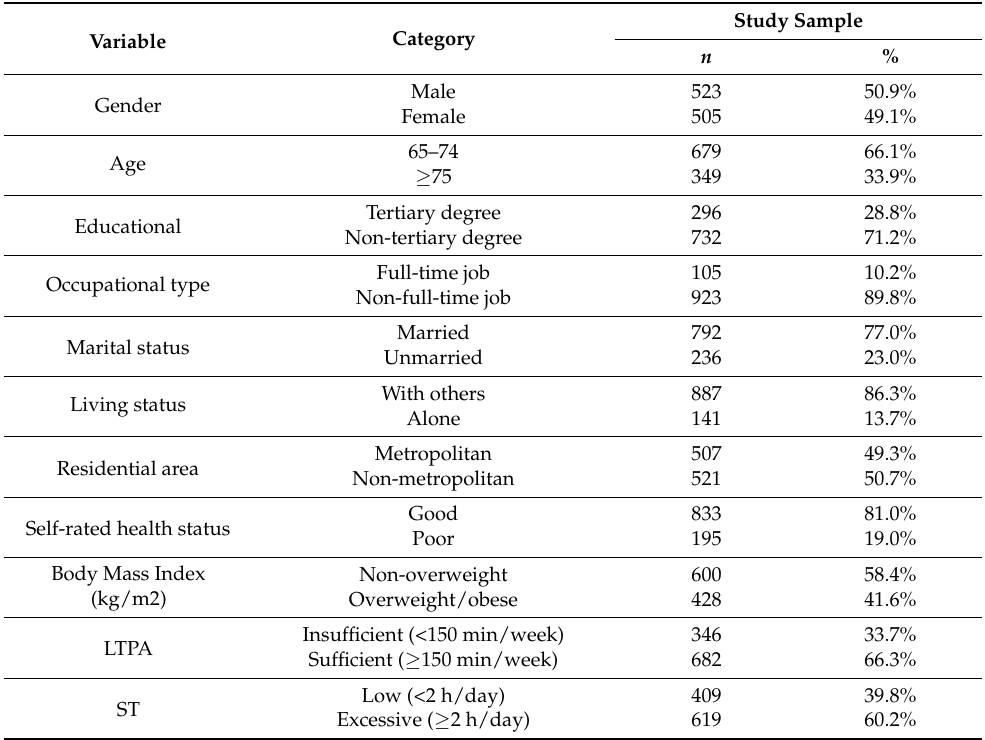
Table 1. Basic characteristics of all respondents ( n =